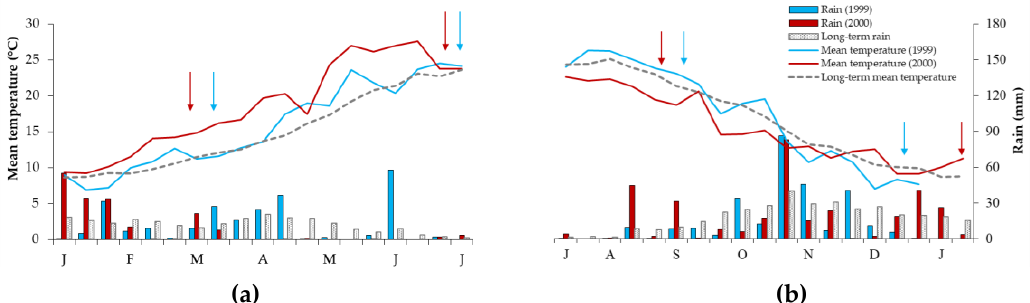
Figure 1. Rainfall (bars) and average temperature (lines) at 10-day interval for Experiment 1 (1999), Experiment 2 (2000) and long-term series (30-year period). Panel ( a ) refers to the period when seed-tuber mother plants were grown and harvest, panel ( b ) refers to the period when the same seed-tubers were tested (Experiment 1, and Experiment 2) at open-field level (from the end of August onwards). Arrows represent approximate planting and harvesting dates of seed-tuber mother plants ( a ) and of experiments at open field level ( b ) for 1999 (light blue) and 2000 (dark red), respectively.